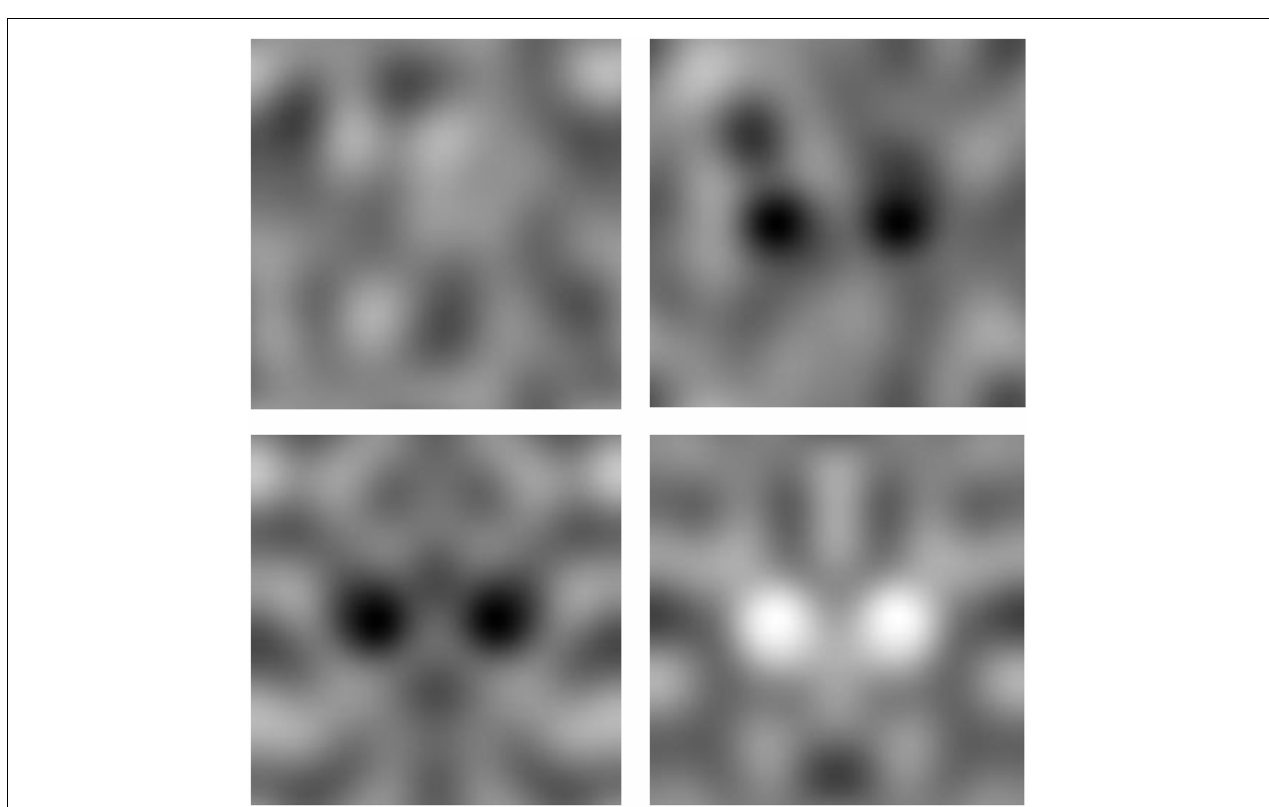
FIGURE 10 | Examples of images with “eyes” added to induce the percept of a face. Top left: noise band-filtered to 2–4 cycles per image to reduce the number of potential features; top right: noise with dark spots added; bottom left: dark spots added to symmetric noise; bottom right: bright spots added to symmetric